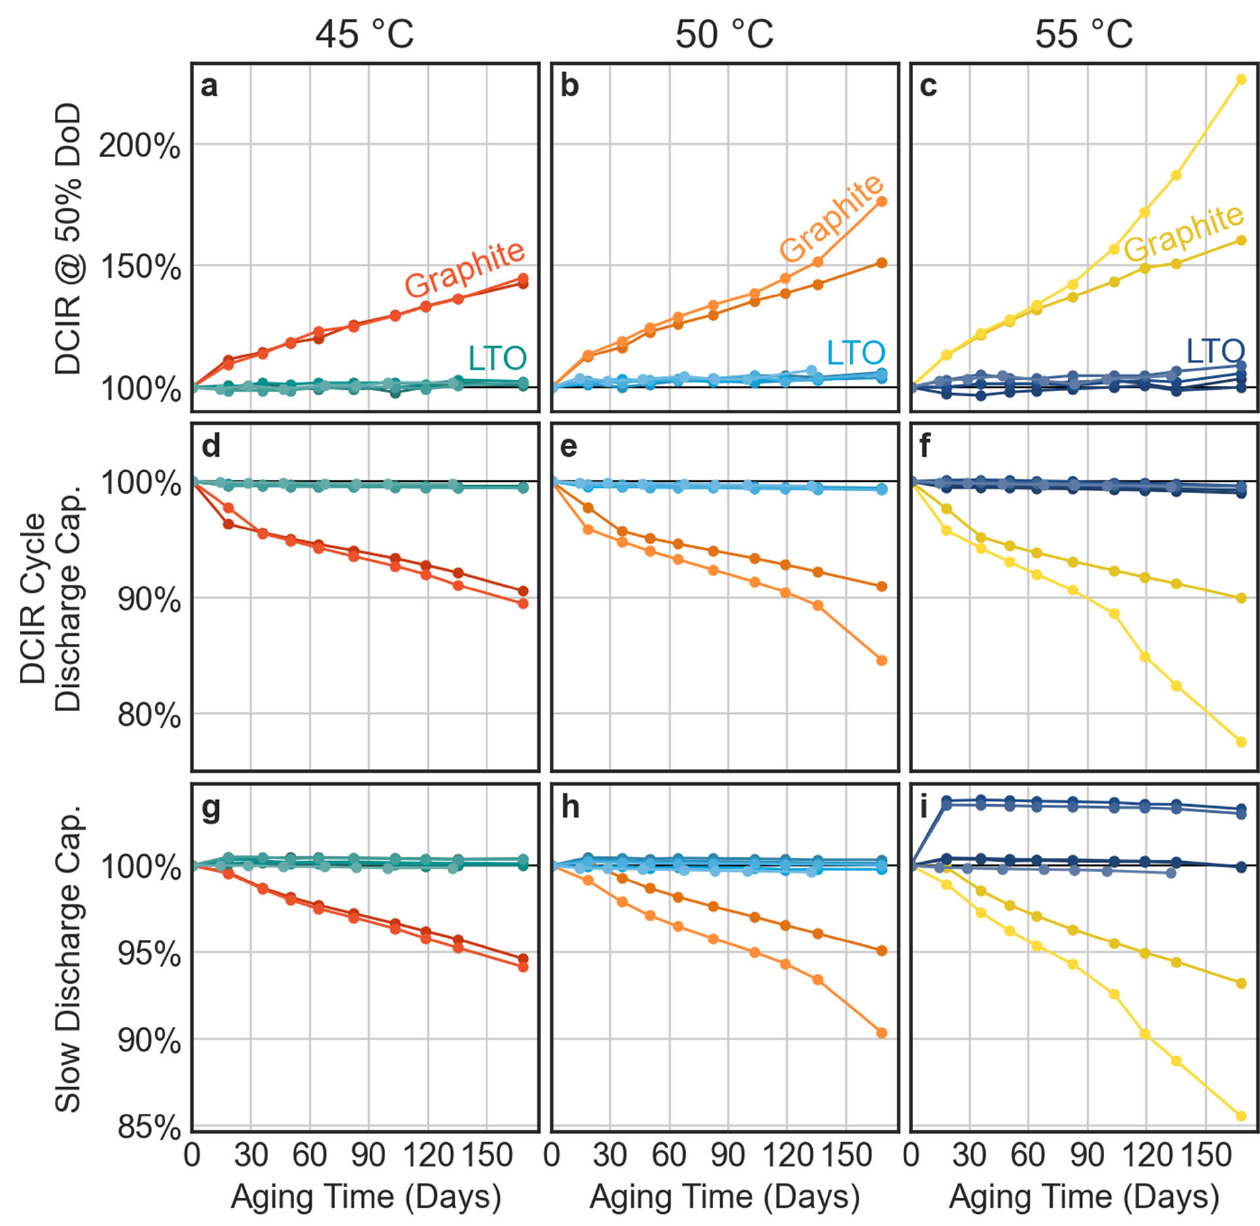
Figure 11. Change in various metrics vs. aging time at 45 ◦ C ( a,d,g ), 50 ◦ C ( b,e,h ), and 55 ◦ C ( c,f,i ). All metrics were normalized relative to the pre-aging value of that metric. Top row ( a,b,c ) DCIR at 50% depth of discharge. Middle row ( d,e,f ) discharge capacity of the DCIR cycle. Bottom row ( g,h,i ) C/24 discharge capacity. The graphite cells are depicted in warm colors (red, orange, yellow) while the LTO cells are depicted in cool colors (teal, blue, navy).